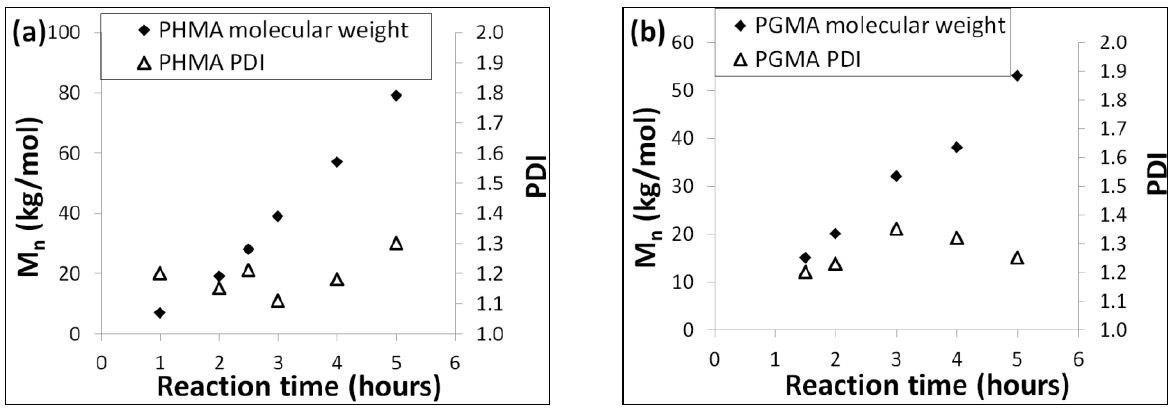
Figure 2. Plots showing the dependence of molecular weight and PDI on reaction time for the RAFT polymerization of HMA ( a ) and GMA ( b ) (5 M in THF) at 60 °C with AIBN as initiator (1.5 × 10 −5 M) mediated with RAFT agent anchored silica nanoparticles (1.5 × 10 −4 M; 0.61 chains/nm 2 ). The gel permeation chromatography (GPC) system was calibrated with poly(methyl methacrylate)